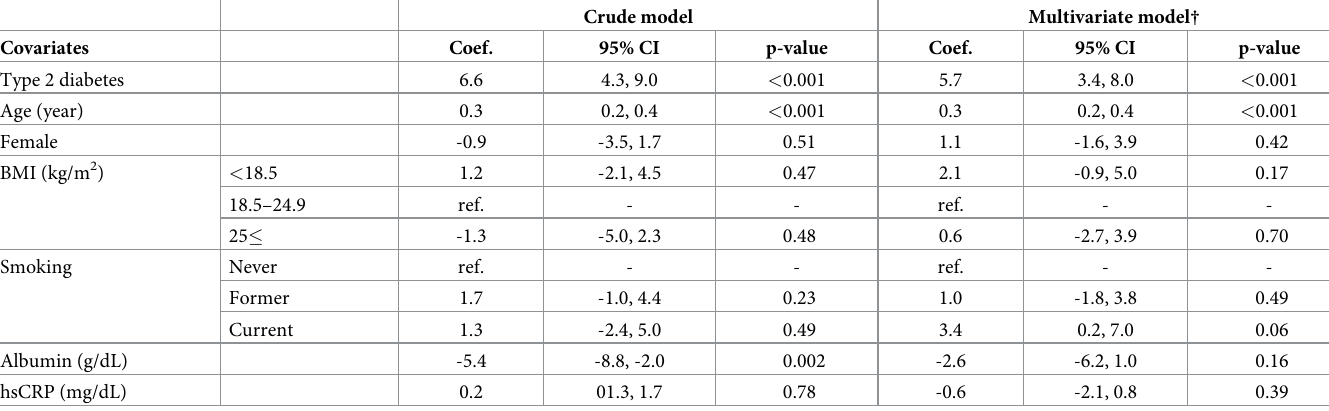
Table 4. Univariate and multivariate regression analysis of the factors influencing the number of missing teeth in the study patients (n = 246). Crude model Multivariate model† Covariates